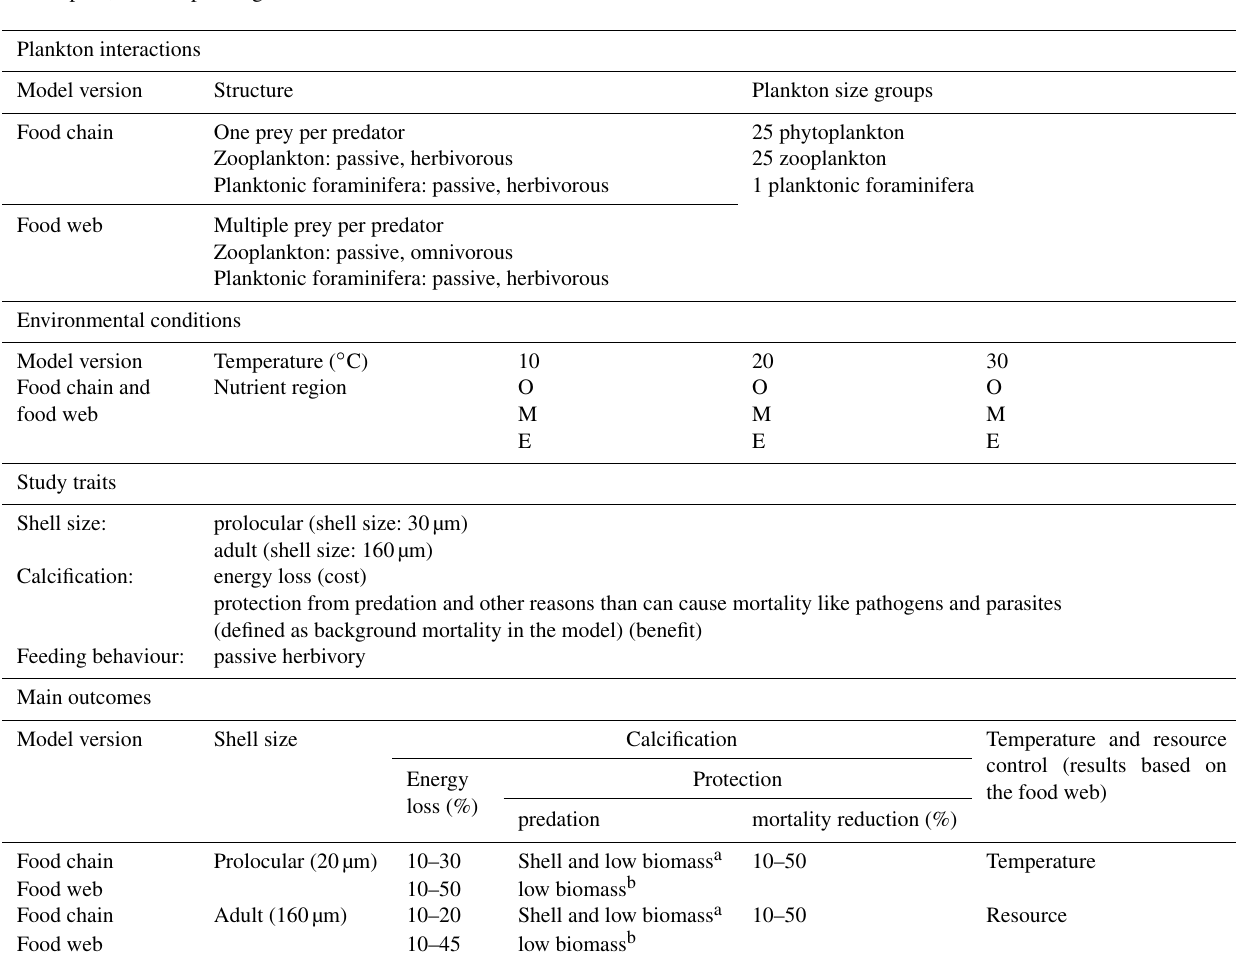
Table 3. Summary of studied traits and environmental conditions for the non-spinose planktonic foraminifera. O: oligotrophic, M: mesotrophic, E: eutrophic